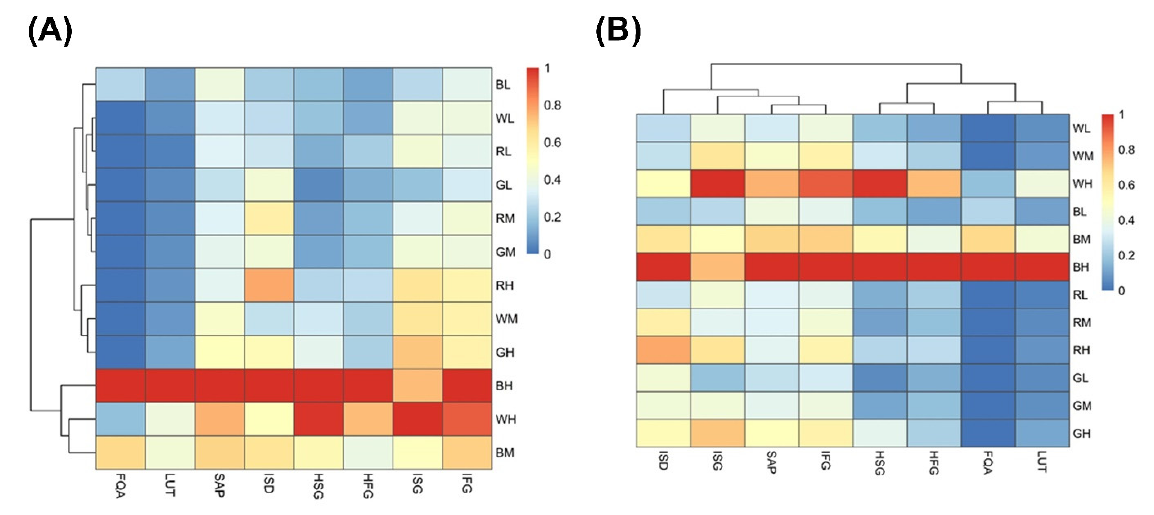
Figure 4. Heatmaps depicting similarities of PheC profiles among light treatments ( A ) as well as similarities in response of individual PheCs to the same light conditions ( B ). The relative contents of each PheC per treatment were averaged ( n = 5–6) and subsequently normalized to the maximum value among all light treatments. Cluster analysis was performed on normalized PheC quantitative data (distance function: Euclidean distance; linkage function: Average linkage). Specifications of light treatments: W (white), B (blue), R (red), G (green), L (low irradiance 100 µmol m − 2 s − 1 ), M (medium irradiance 200 µmol m − 2 s − 1 ), and H (high irradiance 400 µmol m − 2 s − 1 ). Compounds of interest: FQA (feruloylquinic acid), LUT (lutonarin), SAP (saponarin), ISD (isoscoparin derivative), HSG (homoorientin-7-O-[6-sinp]-glc), HFG (homoorientin-7-O-[6-fer]-glc), ISG (isovitexin-7-O-[6-sinp]-glc), and IFG (isovitexin-7-O-[6-fer]-glc).